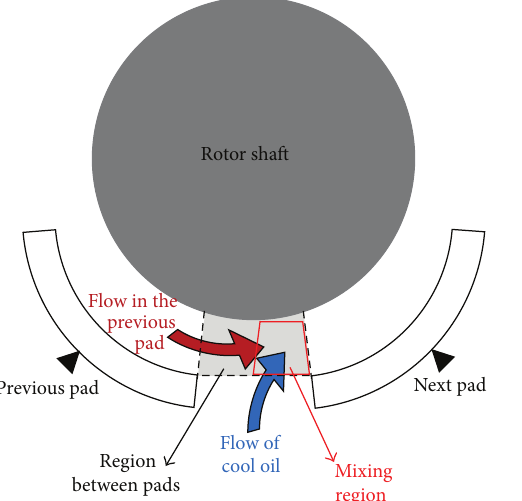
Figure 11: Geometric parameters and clearances in the